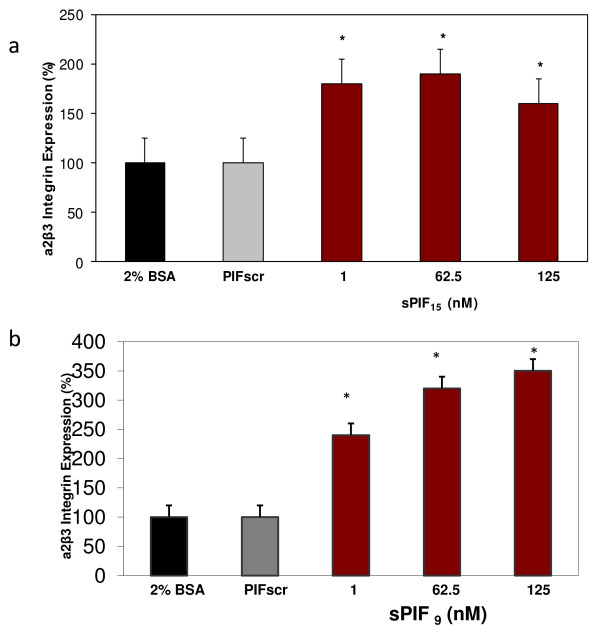
sPIF promotes endometrial receptivity by up-regulating α2β3 integrin. Endometrial epithelial cells were isolated and cultured for 5 days in presence of FCS followed by 24hrs in serum-free media containing 1–125 nM sPIF (15, or 9 aa). At the end of culture cells stained with specific antibody and α2β3 integrin expression was then determined by flow cytometry. Nonspecific IgG isotype served as negative control. a) PIF15 promotes α2β3 integrin in a dose dependent manner as compared with scrambled PIF 125nM or 2%BSA, effect was not significant. b) PIF9 promotes endometrial-α2β3 integrin in a dose dependent manner as compared with 2%BSA, control. Data expressed as (Mean ± SEM.) percent change in basal antigen expression in epithelial cells as compared to negative controls. Data are representative of three different experiments with similar results (ANOVA, *P < 0.05).